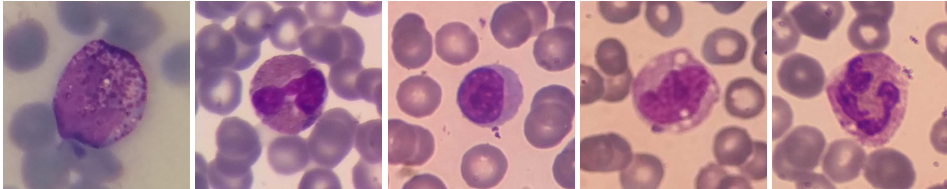
Figure 3. WBC sub-type images from R-WBC. From left to right: Basophil, Eosinophil, Lymphocyte, Monocyte and